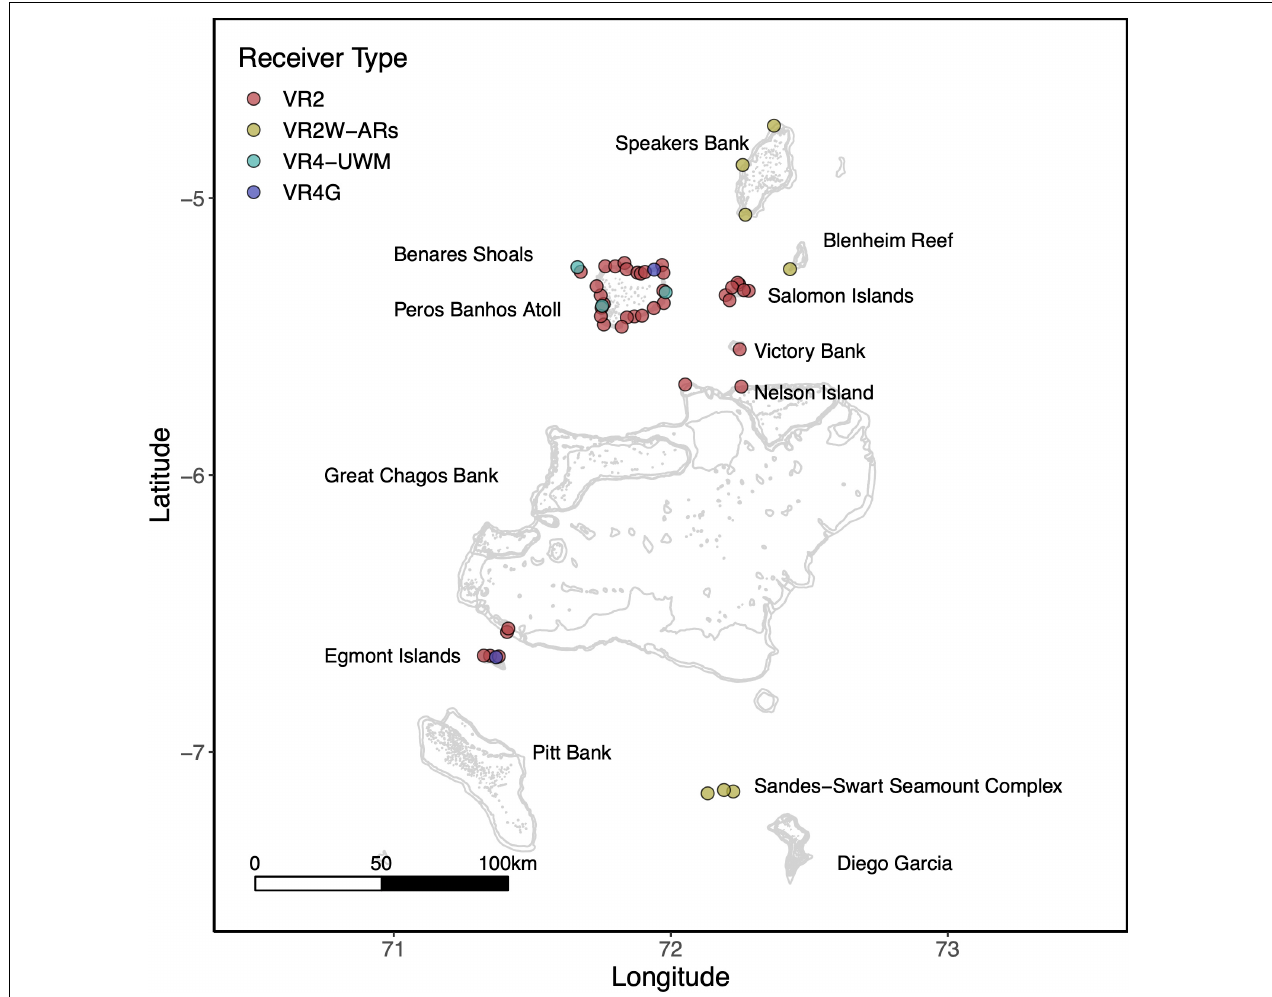
FIGURE 1 | The location of Vemco acoustic receivers across the Chagos Archipelago between March 2018 and March 2019. Colors represent receiver type. Labels depict the location of major island groups, atolls and submerged banks referred to in this